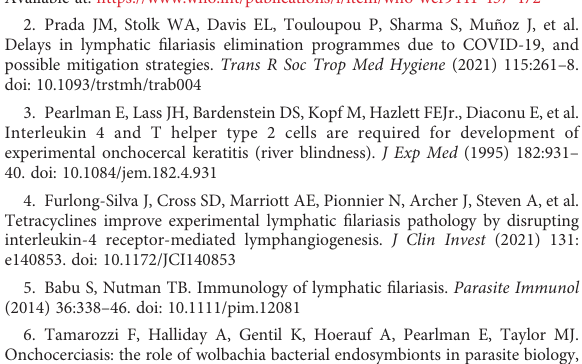
SUPPLEMENTARY FIGURE 1 Flow cytometry gating strategy for leucocytes immunophenotyping. Doublets (A) , debris (B) and dead cells (C) were excluded and pan markers antibodies were utilised for the different cell populations. (D) Eosinophils and neutrophils were gated as SiglecF + Ly6G - and SiglecF - Ly6G + respectively. Innate lymphoid cells (E – H) were pre-gated on lineage negative cell populations (E) (CD8 - , B220 - , F4/80 - , SiglecF - , CD4 - , Ly6G - , Fc g R1 - ) and identi fi ed as CD127 -/low IL-12R b 2 + ST2 - NKp46 - for ILC1s (F) , CD127 low IL-12R b 2 - ST2 + NKp46 - for ILC2s (G) and CD127 -/ low IL-12R b 2 - ST2 - NKp46 + for NK cells (H) . SUPPLEMENTARY FIGURE 2 Short-term temporal ablation of NKp46 + NK cells in RAG2 -/- mice is not suf fi cient to confer treated mice an increased susceptibility to B. malayi parasites. B. malayi infected RAG2 -/- mice were intraperitoneally injected with 0,5mg anti-NKp46 antibody or its isotype control in two occasions (at day 0 and day 3 post-infection) and culled at 1 week post-infection.